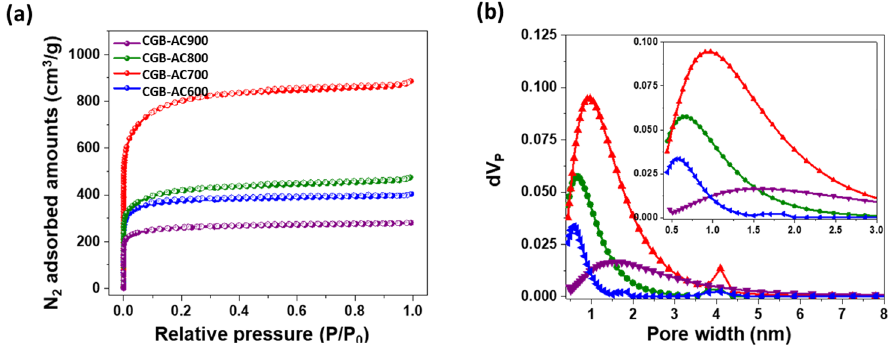
Figure 2. ( a ) N 2 adsorption–desorption isotherms of CGB-AC samples recorded at 77 K and ( b ) pore size distributions of the prepared samples as determined using the NLDFT method. Table 2. Textural properties and hydrogen uptake of the CGB-AC samples.